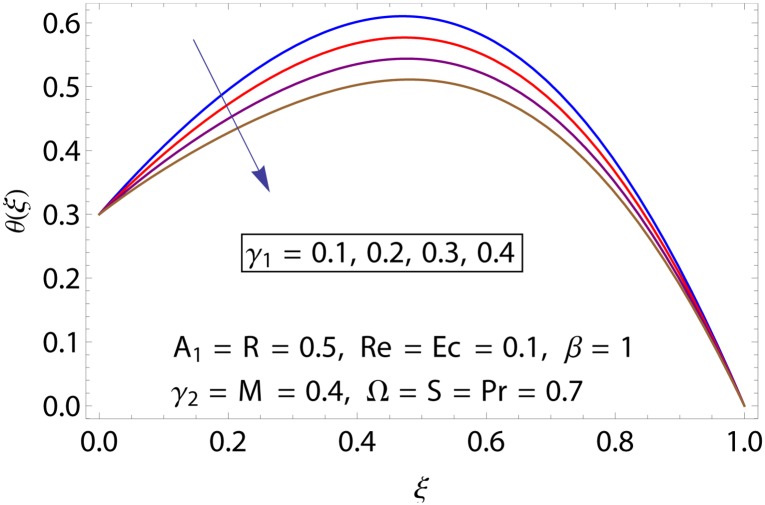
Impact of γ1 on θ(ξ).